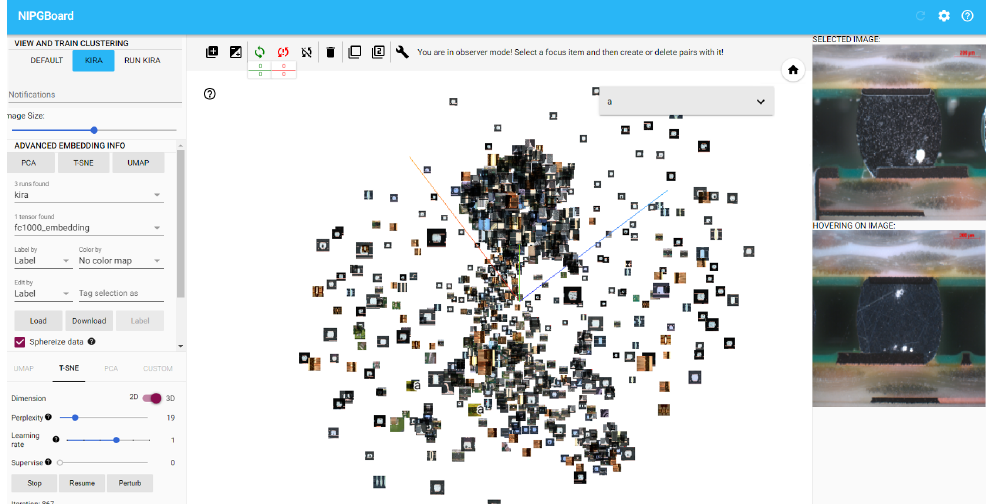
Figure 3. NIPGBoard, a modified TensorBoard interface. ( Left ) methods and parameters of the embedding and dimensionality reduction parameters. ( Middle ) projection panel. ( Right ) higher resolution samples made visible by hovering over the